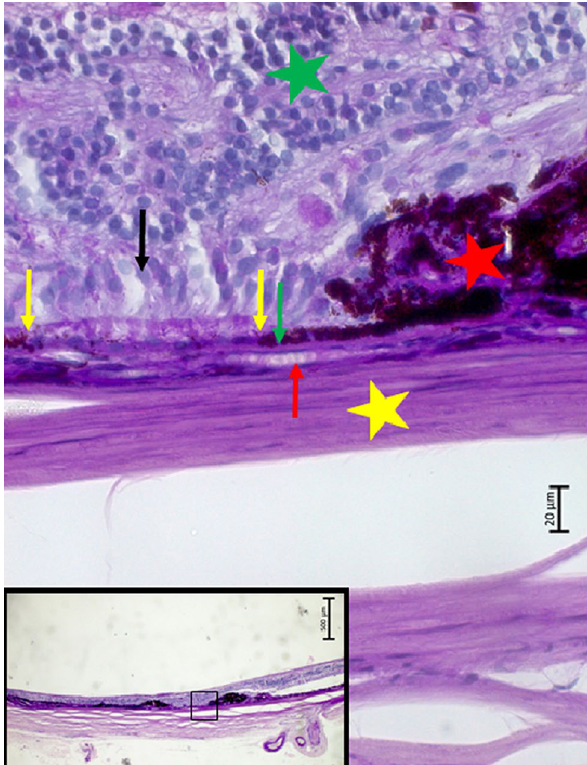
Figure 4. Histophotograph showing an eye with neovascular myopic macular degeneration with irregular proliferations of irregularly pigmented retinal pigment epithelium cells (red asterisks); between yellow arrows: depigmented retinal pigment epithelium, resting on intact Bruch’s membrane (green arrow) and choriocapillaris (red arrow); black arrow: photoreceptors; green asterisks; retina; yellow asterisks: